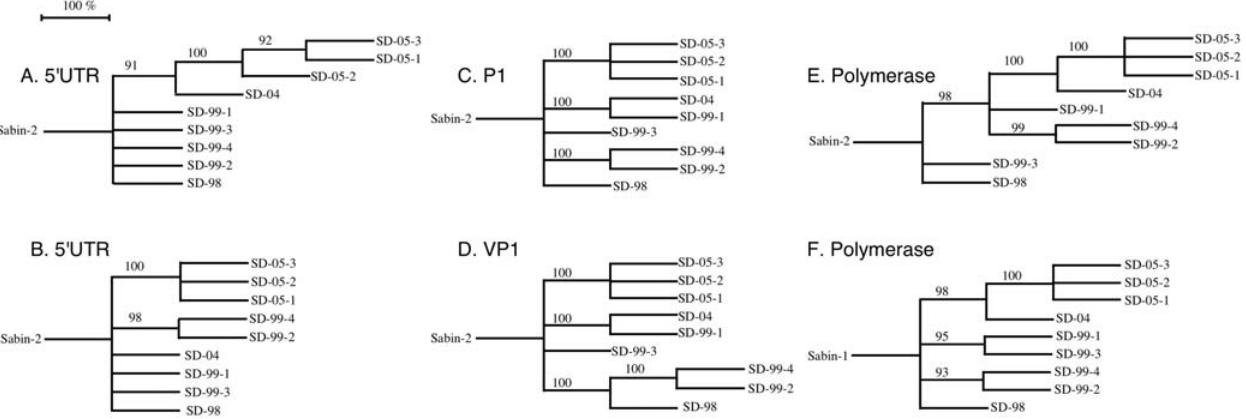
Figure 3. Phylogenetic relationships among Type 2 aVDPVs at 6 locations along the genome. Phylogenetic trees 3A through 3F are maximum likelihood phylogenetic trees for 6 regions distributed along the polioviral genome, two in the 5 9 non-coding region, 2 in the region encoding structural genes and 2 in the region encoding non-structural genes (R1–R6 in Fig. 1). The non-coding regions analyzed are R1 , the 5 9 UTR encoding domains III to VI (Fig. 3A ; nt 196 to nt 645), and R2 , the 5 9 UTR hypervariable region (Fig. 3B : nt 646 to nt 712). The regions encoding structural genes analyzed are R3 , the P1 region encoding all capsid proteins (Fig. 3C ; nt 748 to nt 3384), and R4 , VP1 (Fig. 3D ; nt 2482 to nt 3384). The regions encoding nonstructural genes are R5 , the RNA polymerase gene before the recombination point (Fig. 3E ; nt 5986 to nt 6690), and R6 , the RNA polymerase gene after the recombination point (Fig. 3F ; nt 6700 to nt 7368). Nucleotide positions are given relative to Sabin 2 (Acc: X00595). Trees were prepared using the dnaml maximum likelihood application of the PHYLIP program. The transition:transversion ratio was set at 10, data was bootstrapped 100 times and the order of sequences for each bootstrap randomized 3 times. Trees A through E are rooted to Sabin 2, while tree F is rooted to Sabin 1(Acc: V01150). Branch lengths correspond to the number of times a given branch appears among all bootstrapped trees. All branches with bootstrap values , 90% have been collapsed. The trees were visualized using the njplot